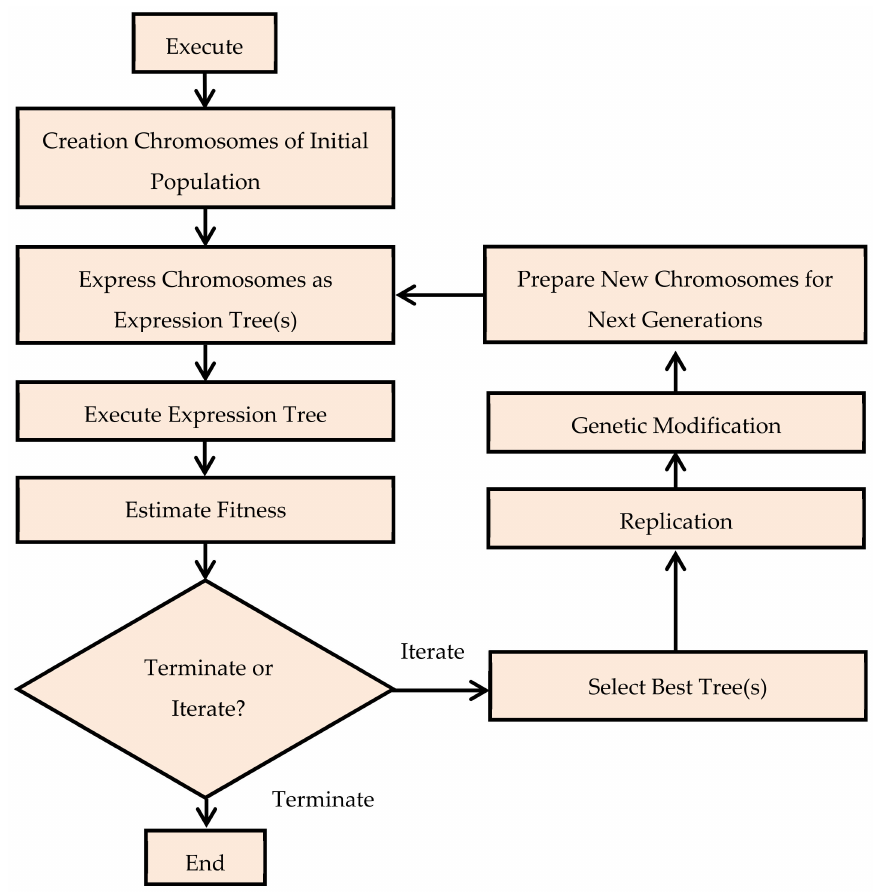
Figure 5. Flow chart of the GEP